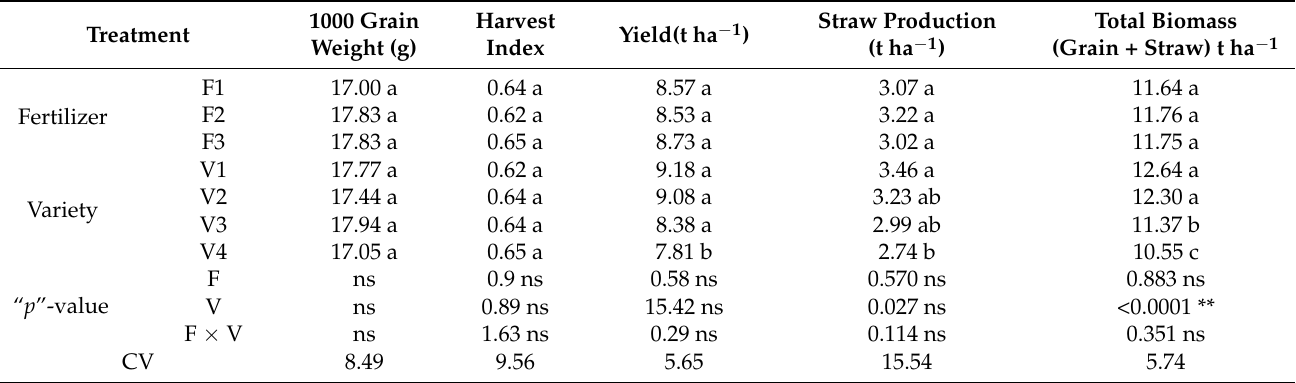
Table 7. The average of 1000 grain weight, harvest index, yield, straw production, and total biomass of the study in karst dryland, in Gunungkidul, WS 2019/2020.